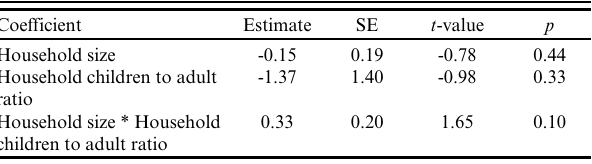
Table 1 . Output from multiple linear regression. Fig. 3 . The livelihood activities recorded in the survey